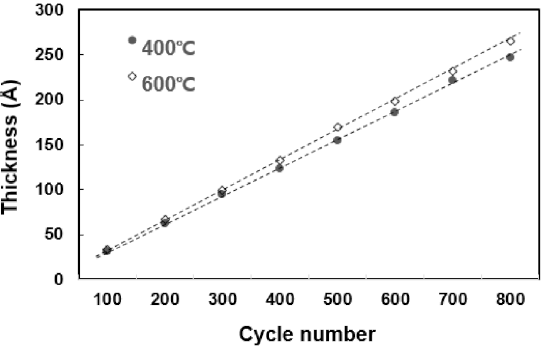
Figure 3. The tendency of deposition thickness as the number of deposition cycles